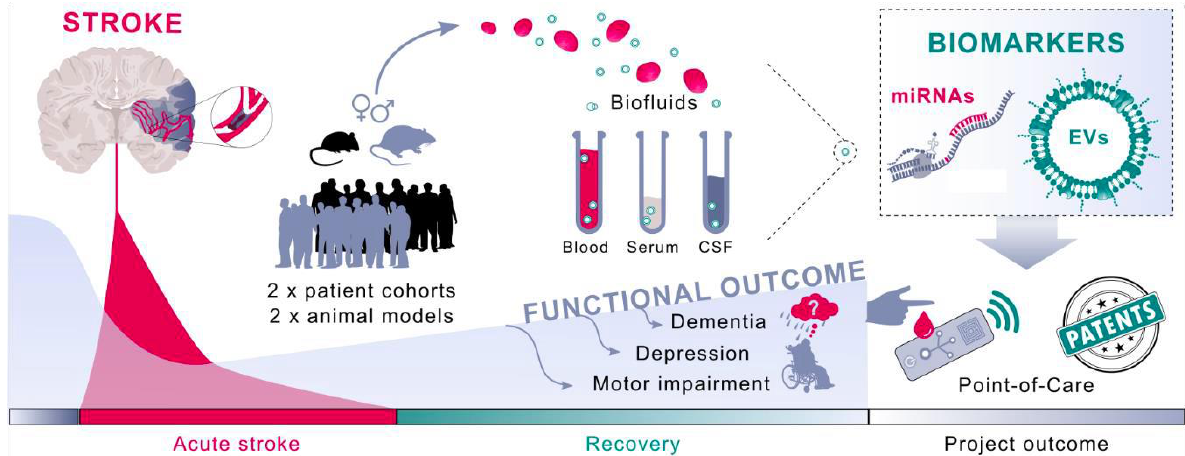
Figure 2. Biofluids (blood and CSF) are sampled from animals and patients acutely after ischemic stroke, and omic profiles isolated are used to develop artificial intelligence-based algorithms able to predict long-term outcomes after stroke in individual patients. Using this approach, we will be able to identify patients at risk for unfavourable outcomes after stroke in the future and direct them towards effective therapies.